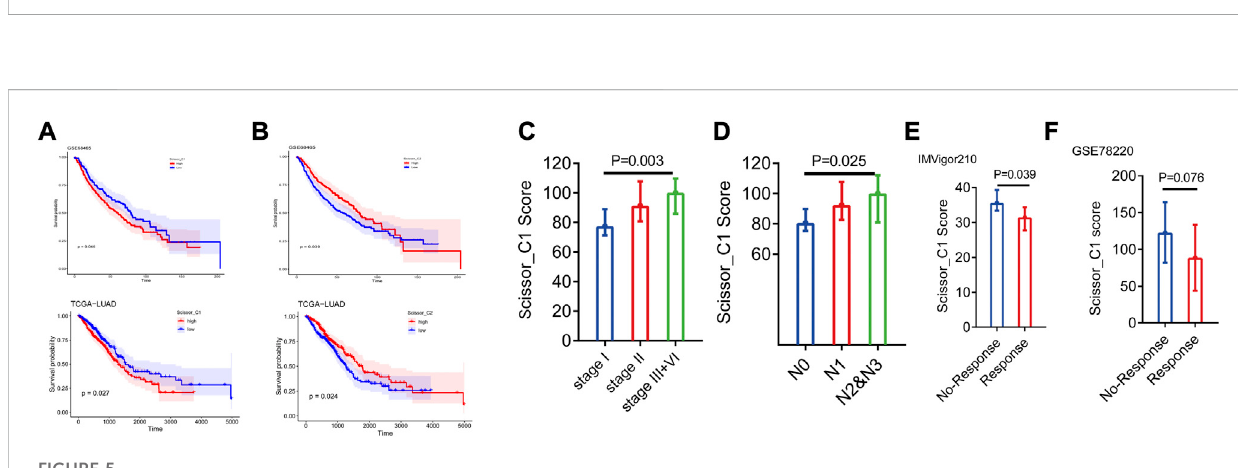
Frontiers in Cell and Developmental